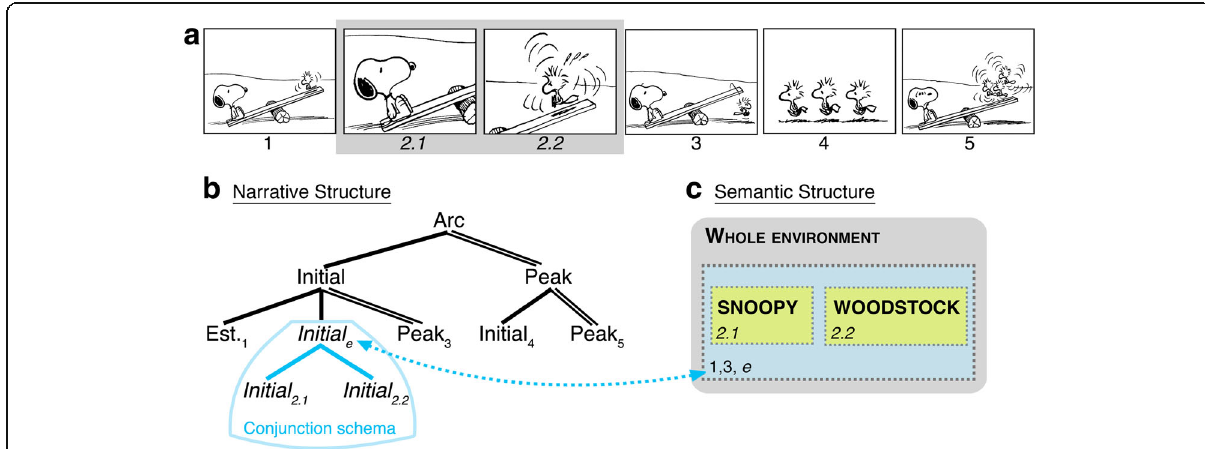
Fig. 2 ( a ) Visual narrative sequence where single characters are framed in separate panels, causing ( b ) the narrative structure to use using E(nvironmental)-Conjunction, which ( c ) maps to a semantic structure requiring a spatial